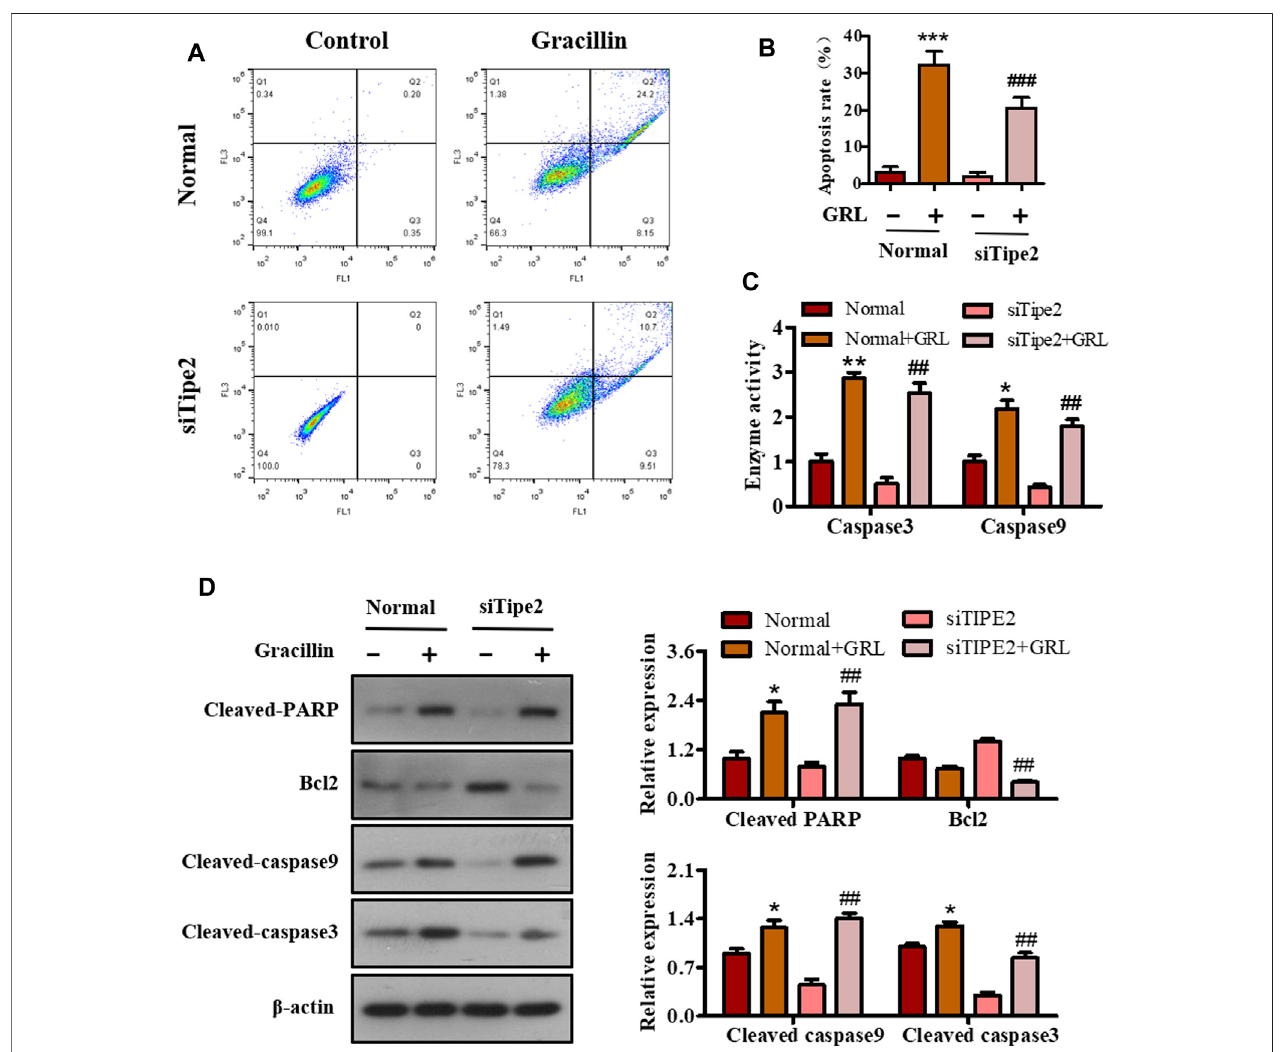
FIGURE7| TheroleofTIPE2inthecellapoptosismediatedbygracillininBGC823cells. (A) FlowcytometerforcellapoptosisbyTIPE2andgracillin.BGC823 cells and TIPE2 siRNA BGC823 cells were treated with 3 μ M gracillin for 24 h. (B) The quantitative analysis of cell apoptosis. (C) Elisa assay for the enzyme activities of caspase three and caspase 9. (D) Western blot for the expression of cleaved PARP, bcl2, cleaved caspase 9, and cleaved caspase 3. 0.01 < p < 0.05 (*) represents a signi fi cant difference, 0.001 < p < 0.001 (**) represents a very signi fi cant difference and p < 0.001 (***) represents an extremely signi fi cant difference to the normal control; 0.01 < p < 0.05 ( # ) represents a signi fi cant difference, 0.001 < p < 0.01 ( ## ) represents a very signi fi cant difference and p < 0.001 ( ### ) represents an extremely signi fi cant difference to the TIPE2 siRNA